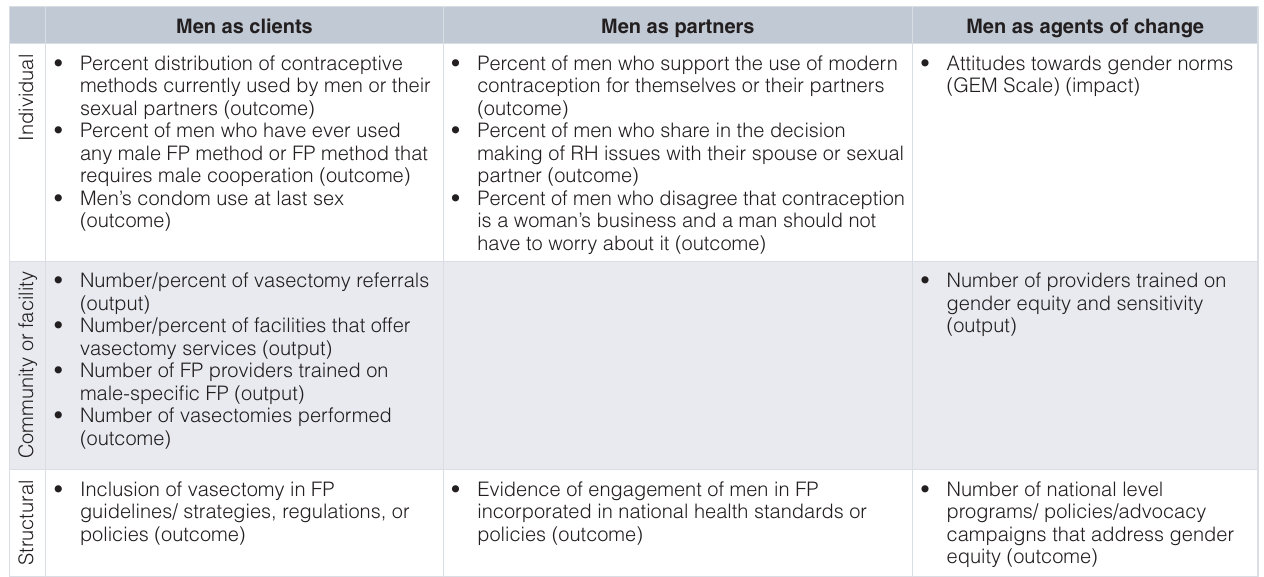
Table 3. Recommended key indicators for monitoring and evaluation of male engagement in family planning